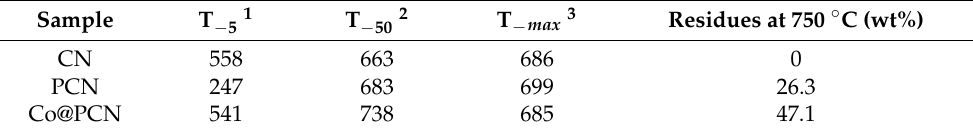
Figure 4. ( a ) TG and ( b ) DTG curves of three kinds of flame retardants in nitrogen atmosphere. Table 2. The related data of three kinds of flame retardants in nitrogen atmosphere.